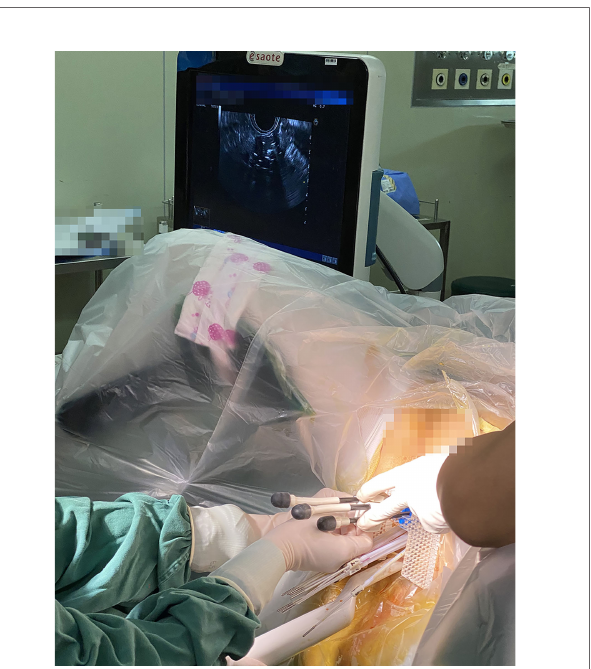
FIGURE 1 | Use of hybrid intracavitary and interstitial (IC/IS) brachytherapy with assistant of real-time transrectal ultrasound. All the implants were MR